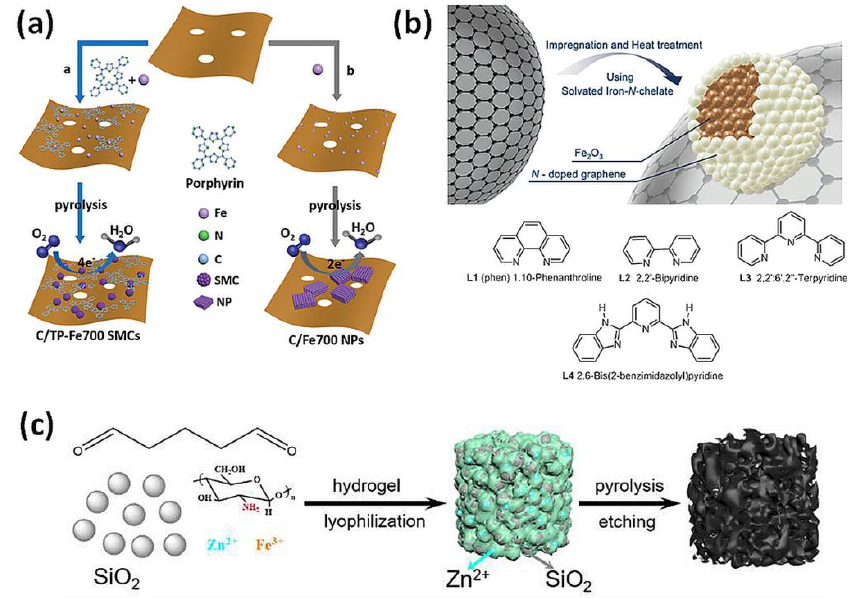
Figure 4. Heterogeneous catalysts: ( a ) Synthetic routes for the preparation of iron (Fe) single clusters immobilized on N -doped porous carbon (C / TP-Fe700 SMCs) and iron-based nanoparticles (C / Fe700 NPs) [83]. Reprinted with permission from WILEY-VCH Verlag GmbH & Co. KGaA, Copyright 2018.